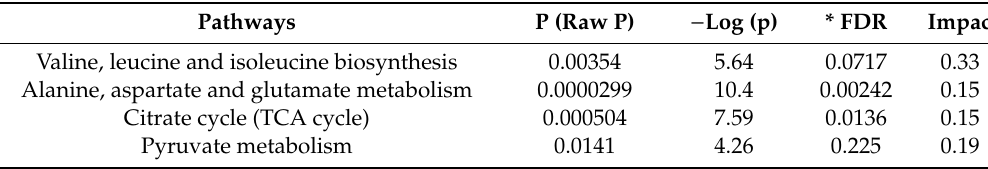
Table 2. Pathway analysis with